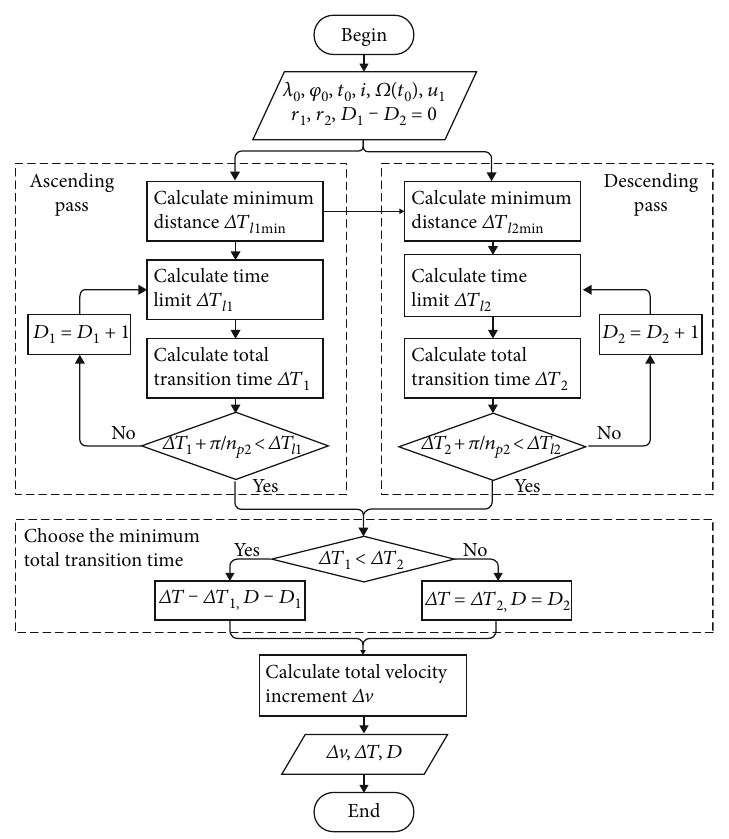
Figure 4: Mathematical model for one satellite monitoring one